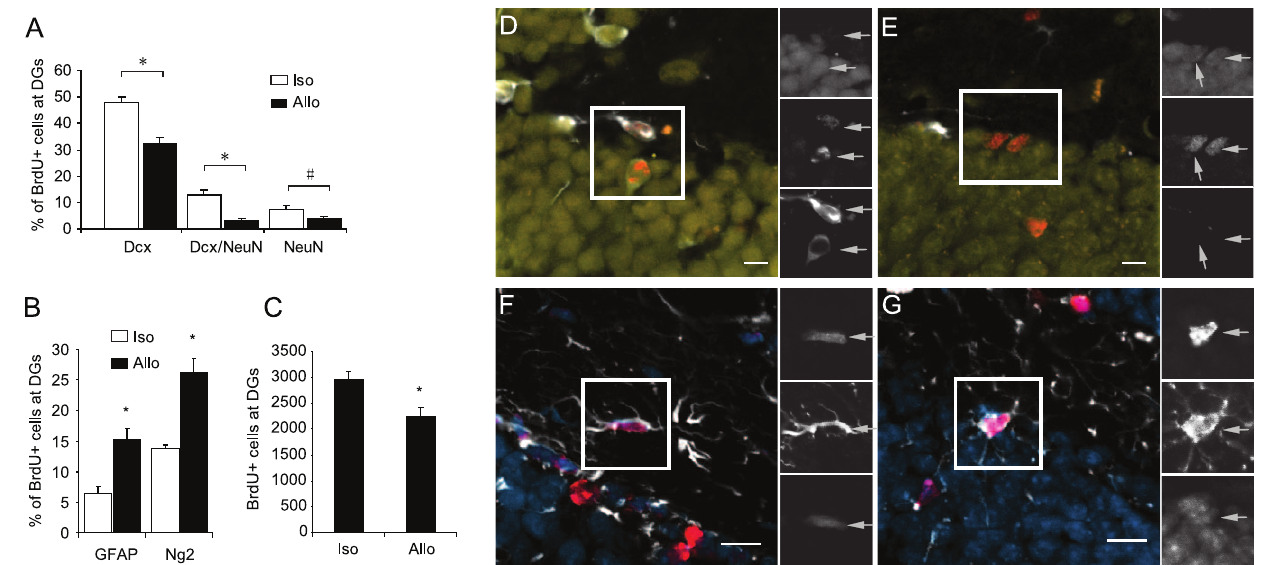
Figure 3. Allograft-induced signaling blocks endogenous neurogenesis and favors glial production. C57BL/6 mice were given one i.p. BrdU injection daily for 6 consecutive days followed by transplantation of isogenic or allogeneic NPCs on day 7. Two weeks after transplantation, brains were harvested and examined for cell-type specific markers in the endogenous BrdU-labeled progenitors. ( A,B ) the percentage of cells staining positive for each marker or markers was quantified. Fewer immature (Dcx + alone), transitional (Dcx + /NeuN + ) and mature (NeuN + alone) neurons but more GFAP + astrocytes and NG2 + oligodendrocytes derived from endogenous NPCs were observed in allograft vs. isograft group. * p , 0.05; # p , 0.1, n=4, compared to isograft. ( C ) The total number of BrdU-labeled endogenous NPCs at the DGs per mouse was scored. Significantly fewer BrdU + endogenous NPCs were found in allograft vs. isograft groups, (* p , 0.05, n=4). ( D–G ) Representative pictures of Dcx (D), NeuN (E), GFAP (F) and NG2 + (G) cells differentiated from BrdU-labeled endogenous NPCs. Red, BrdU; Yellow, NeuN; blue, DAPI; white, Dcx (D and E), GFAP (F) or Ng2 (G). Scale bar, 10 m m.